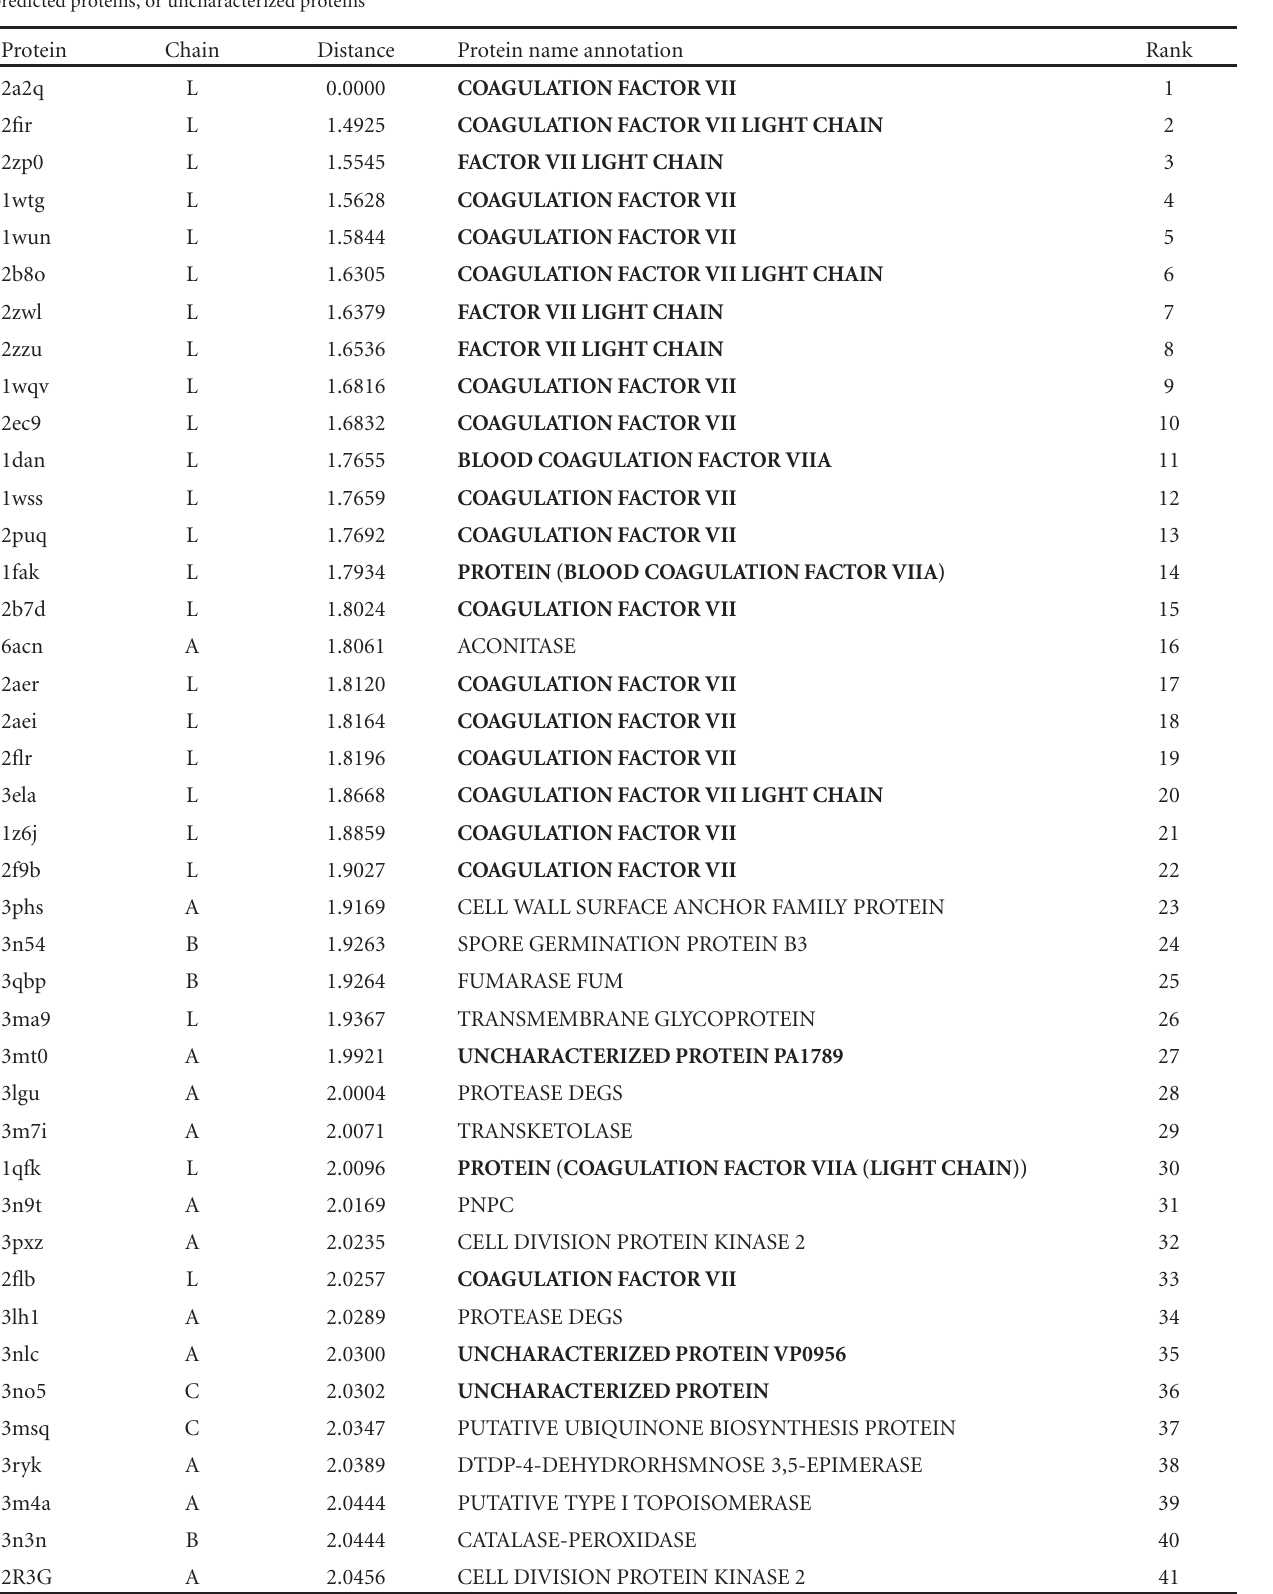
(a) Top 50 hits using DRC for a query protein structure from the EGF family on DATASET-B. Annotations in bold correspond to members of the EGF family, predicted proteins, or uncharacterized proteins Protein Chain Distance Protein name annotation